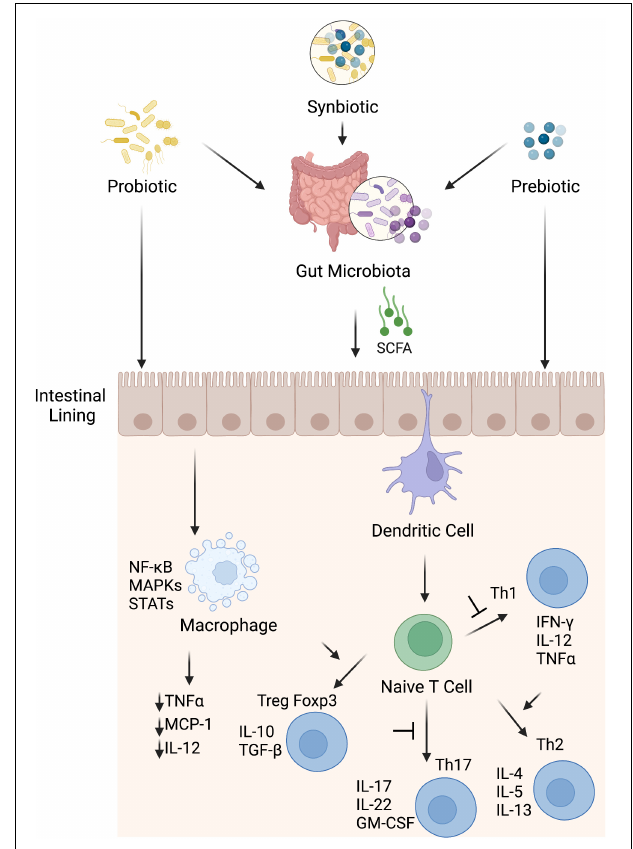
FIGURE 3 | Potential anti-inflammatory mechanisms induced by probiotics, prebiotics and synbiotics. Probiotic, prebiotic and synbiotic can stimulate anti-inflammatory components of the immune system directly or indirectly through modulation of gut microbiota. These interventions interact with sentinel cells such as dendritic cells and macrophages through membrane receptors e.g., PRRs and suppress inflammation. Dendritic cells induce anti-inflammatory state through blocking transformation of naïve T cells into Th1 and Th17 cells and promote proliferation of Treg cells that consequently with help of their cytokines like IL-10 and TGF- β skew immune homeostasis toward anti-inflammatory state. Macrophages, once activated, produce different types of pro-inflammatory cytokines to promote inflammation but microbiota derived SCFA, especially butyrate, hinder different pathways like MAPK, STAT and NF-kB and suppress pro-inflammatory cytokines (monocyte chemotactic protein-1, TNF- α , and IL-12) from macrophages to suppress